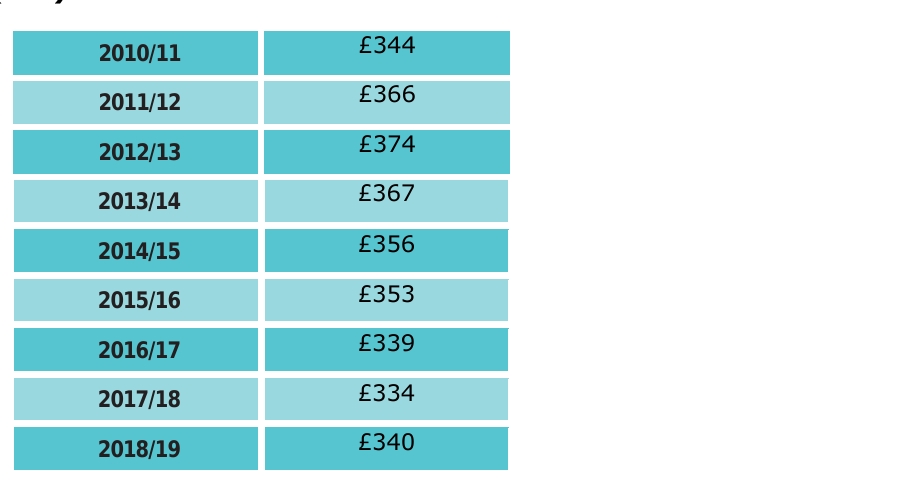
Table 6: Local authority spending on disabled children’s services in real ter ms (mn)